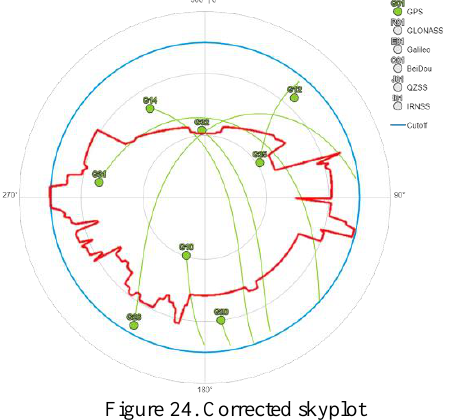
Figure 24. Corrected